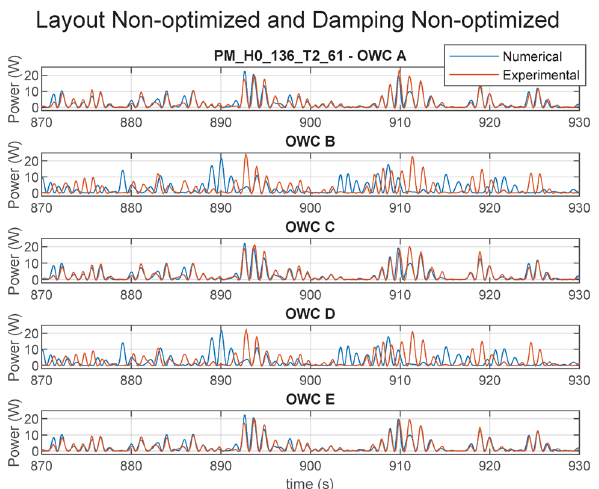
Fig. 10. Comparison of Power time series between experimental and numerical (WEC-Sim) results for a irregular wave with , . WEC-Sim gives a reasonable estimate for OWC A, C, and E, however phase and amplitude are off on B and D. 0.136 𝑚𝑚 𝑇𝑇 𝑝𝑝 = 2.61 𝑠𝑠